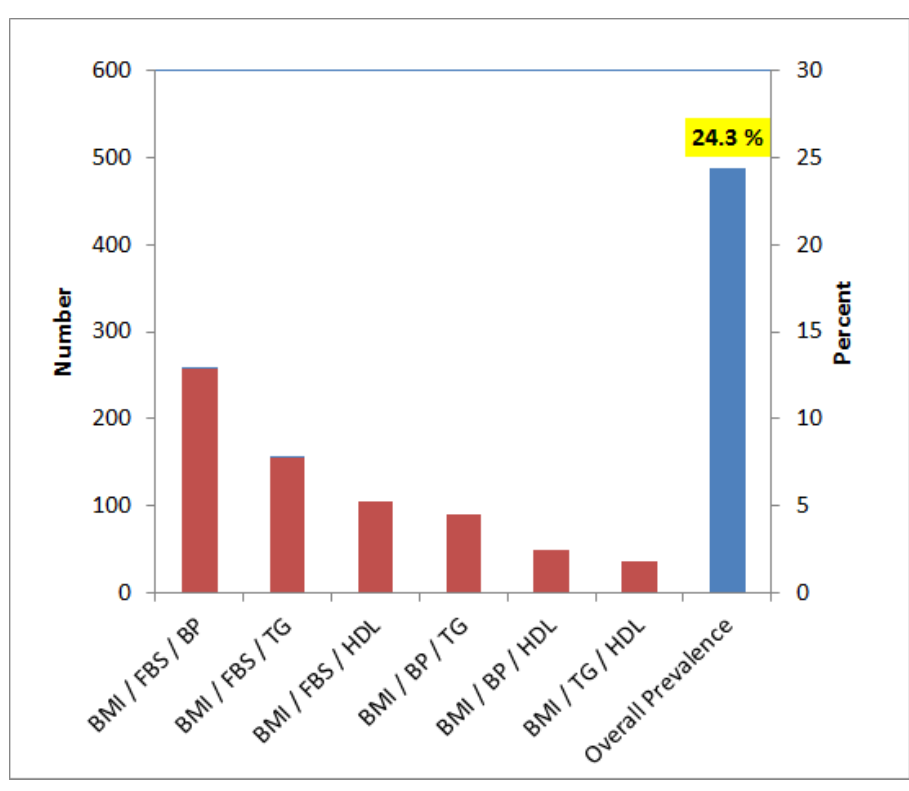
Figure 1. Prevalence of Met-S using various triplet components. Blue bar shows cumulative filter counts from all six triplets of Met-S components.